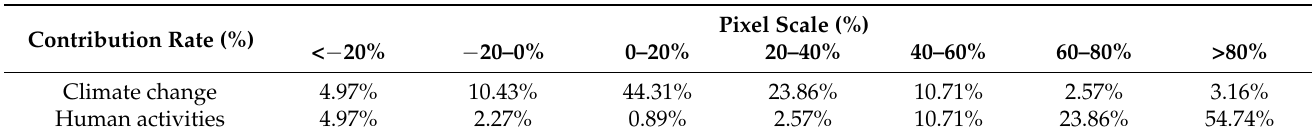
Table 7. Statistics of the contribution rates of climate change and human activities to vegetation cover change in the Yangtze River Basin.